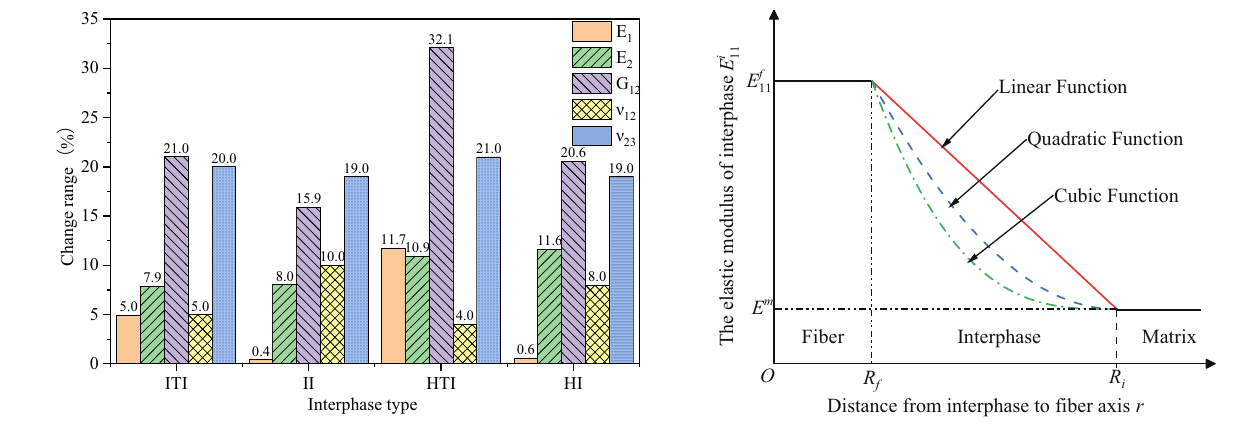
Figure 14: Gradients of elastic modulus of interphase material with di ff